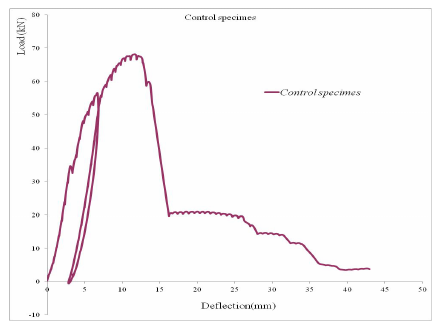
Figure 3: Bearing support frame structure Figure 4: Testing configuration for reference sample